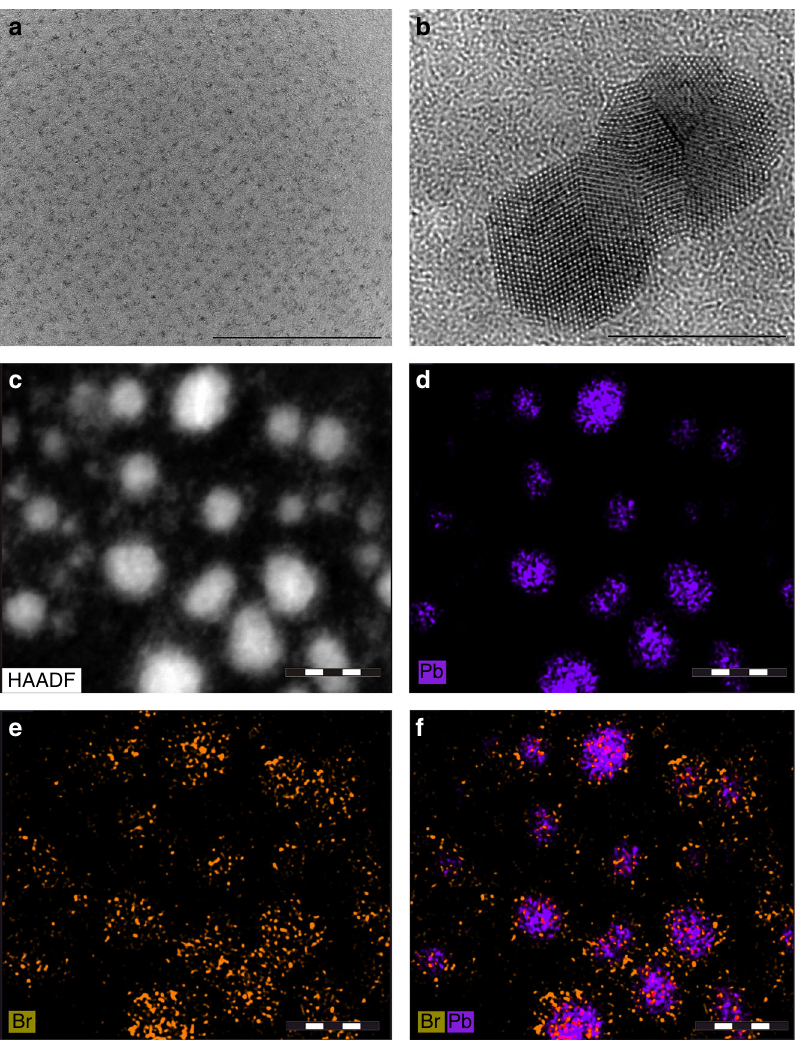
Fig. 2 Structural and compositional analysis of CH 3 NH 3 PbBr 3 NCs. a TEM overview image of CH 3 NH 3 PbBr 3 NCs ( scale bar , 100 nm) and b HRTEM image of selected larger CH 3 NH 3 PbBr 3 NCs (1×) synthesized at room temperature ( scale bar , 10 nm). c HAADF image and d – f corresponding elemental mapping of Pb and Br in CH 3 NH 3 PbBr 3 NCs ( scale bar , 20